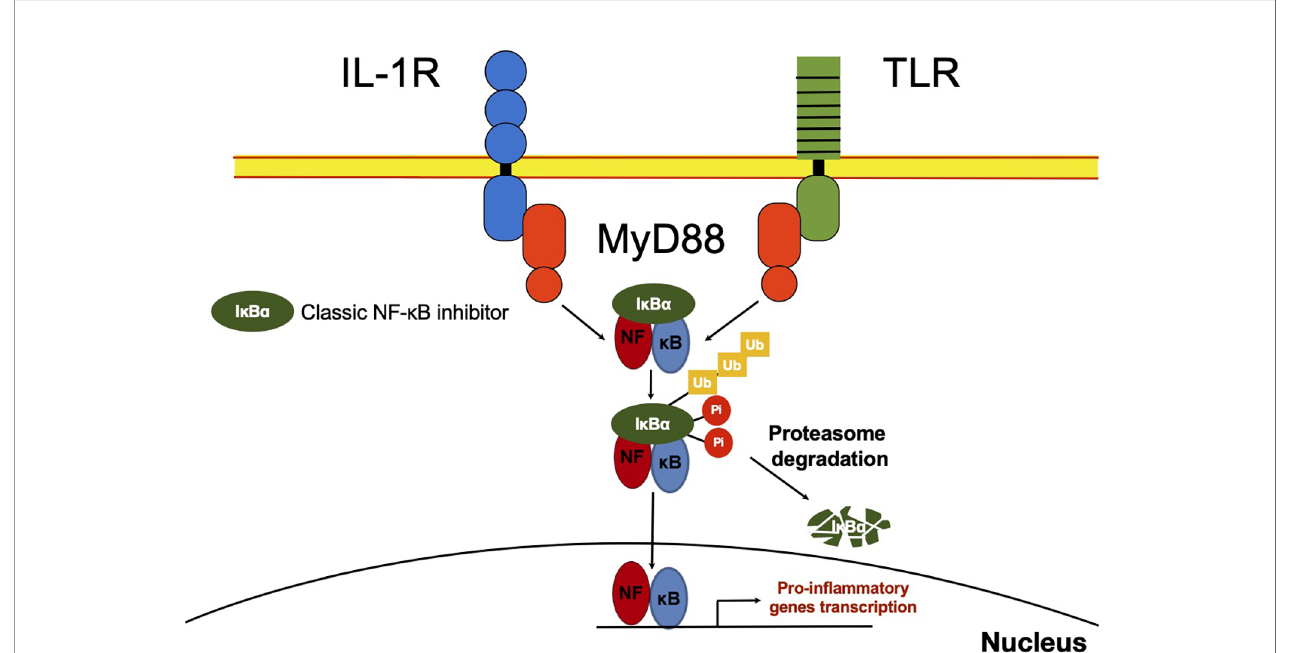
FIGURE 2 | NF- k B classic activation. After recognition of IL-1R or TLR ligands, MYD88 promotes activation of the IKK complex, which mediates I k B phosphorylation. I k B ⍺ phosphorylated, in turn, is ubiquitinated and delivered to the proteasome where it is degraded. NF- k B released in the cytoplasm can now translocate to the nucleus and promote transcription of several primary response genes. Most of these genes are related to in fl ammation such as TNF a , IL-1 b , I k B z and I k